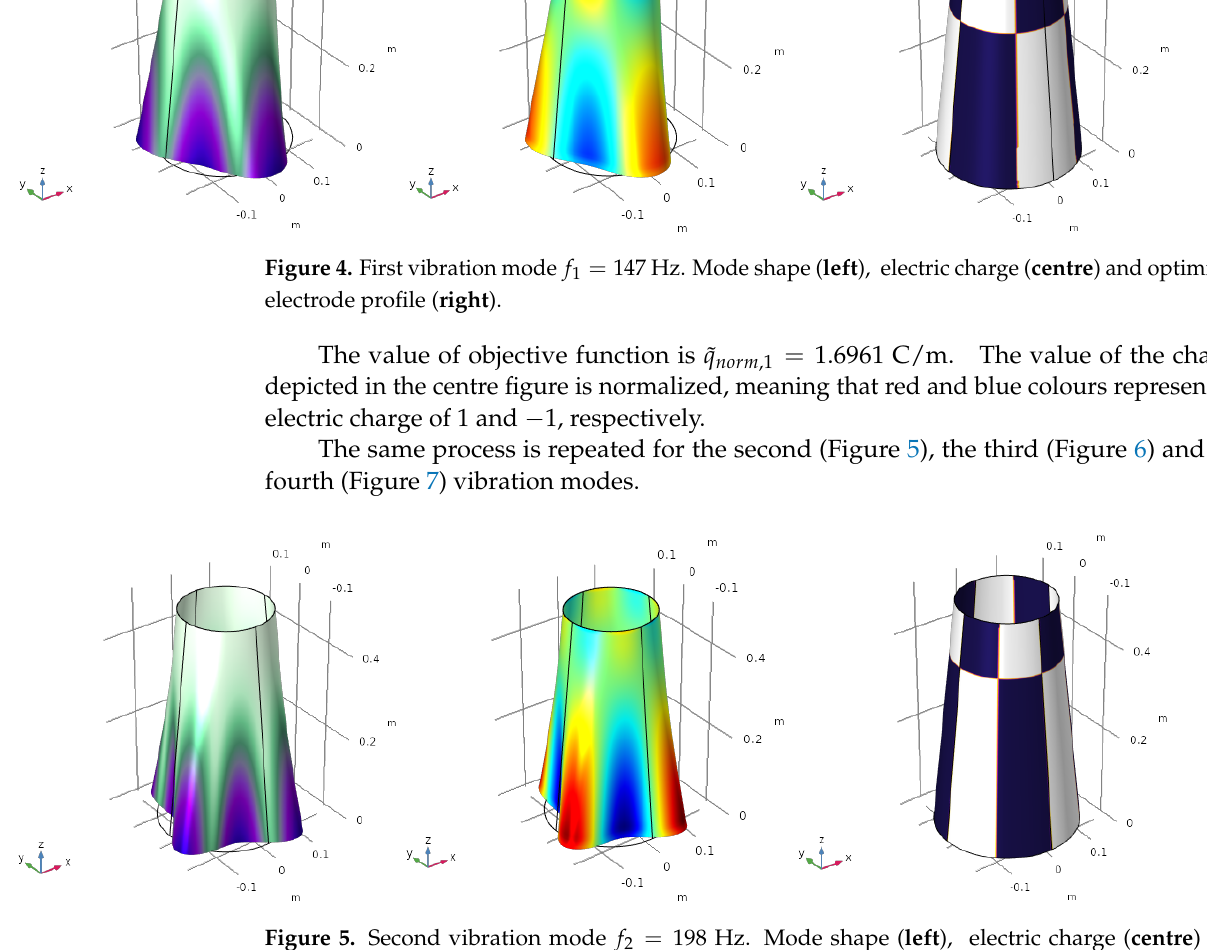
Figure 5. Second vibration mode f 2 = 198 Hz. Mode shape ( left ), electric charge ( centre ) and optimized electrode profile ( right